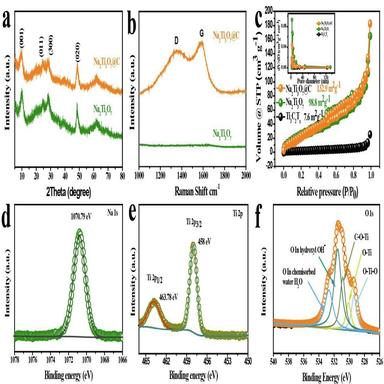
(a) XRD patterns Na2Ti3O7 and Na2Ti3O7@C. (b) Raman spectra of Na2Ti3O7@C and Na2Ti3O7. (c) Pore size distribution and nitrogen sorption isotherms of Na2Ti3O7@C, Na2Ti3O7 and Ti3C2Tx. (d–f) Na 1s, Ti 2p and O 1s XPS spectra of Na2Ti3O7@C, respectively.